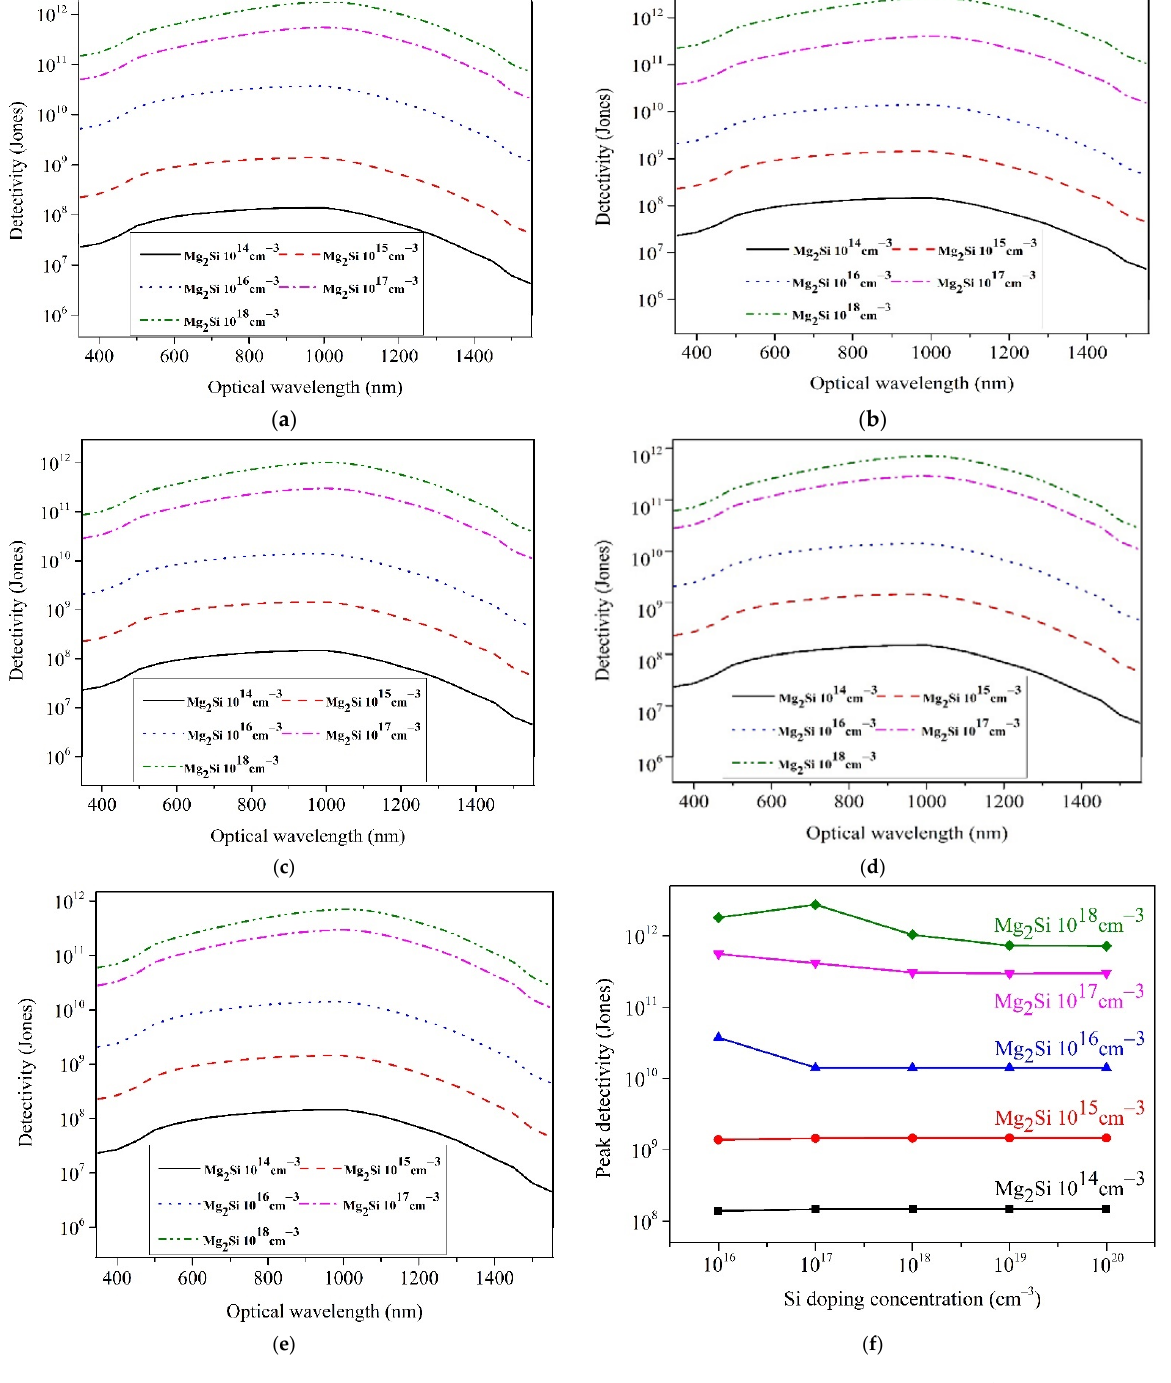
Figure 9. Detectivity curves of the heterojunction PDs with different doping concentrations. ( a ) Si–10 16 cm − 3 . ( b ) Si–10 17 cm − 3 . ( c ) Si–10 18 cm − 3 . ( d ) Si–10 19 cm − 3 . ( e ) Si–10 20 cm − 3 . ( f ) The effect of doping concentrations on